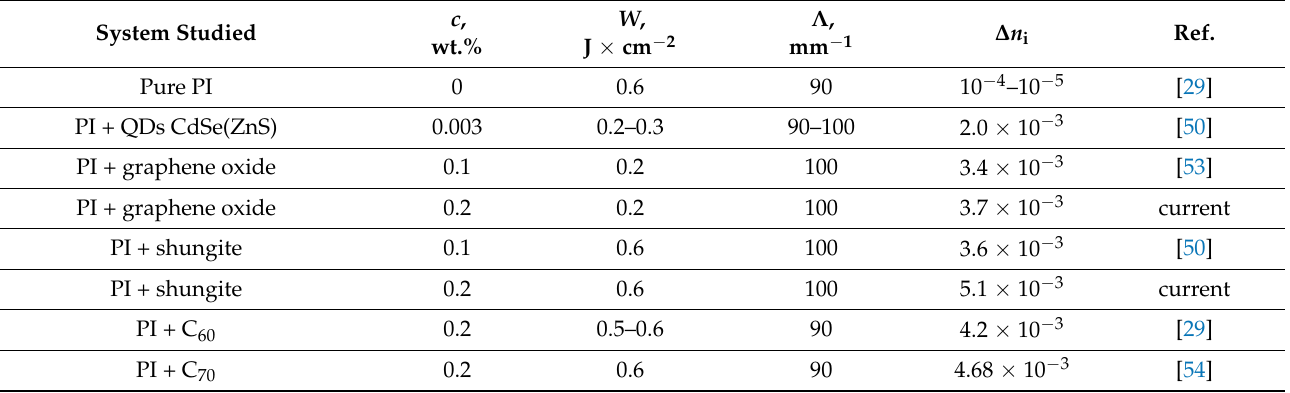
Table 1. Laser-induced change of the refractive